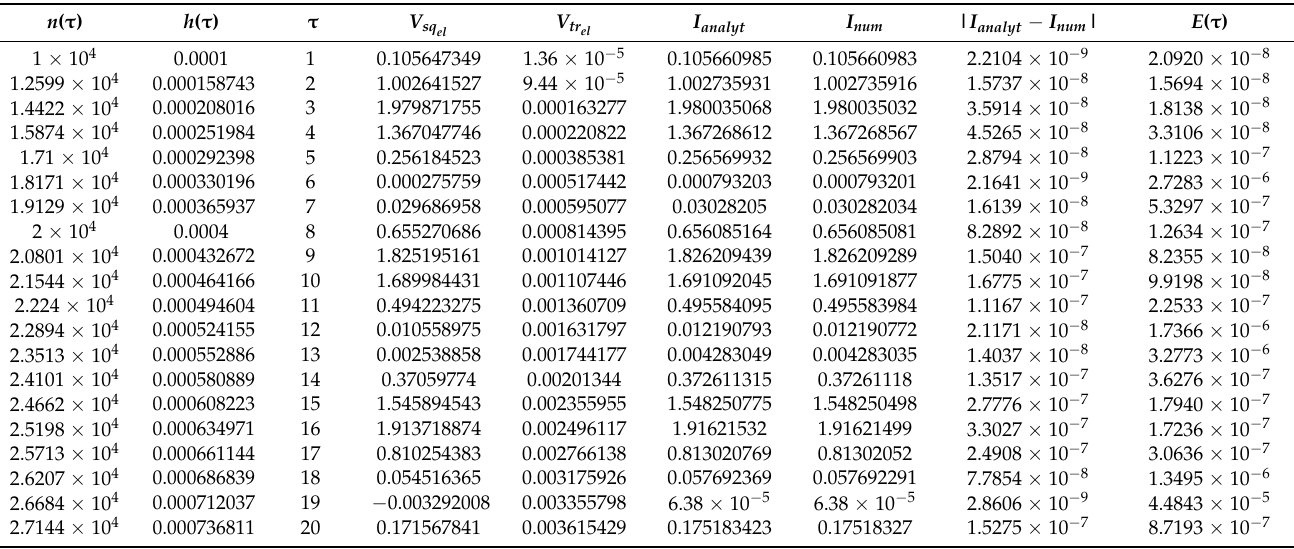
Table 11. Calculation of integral